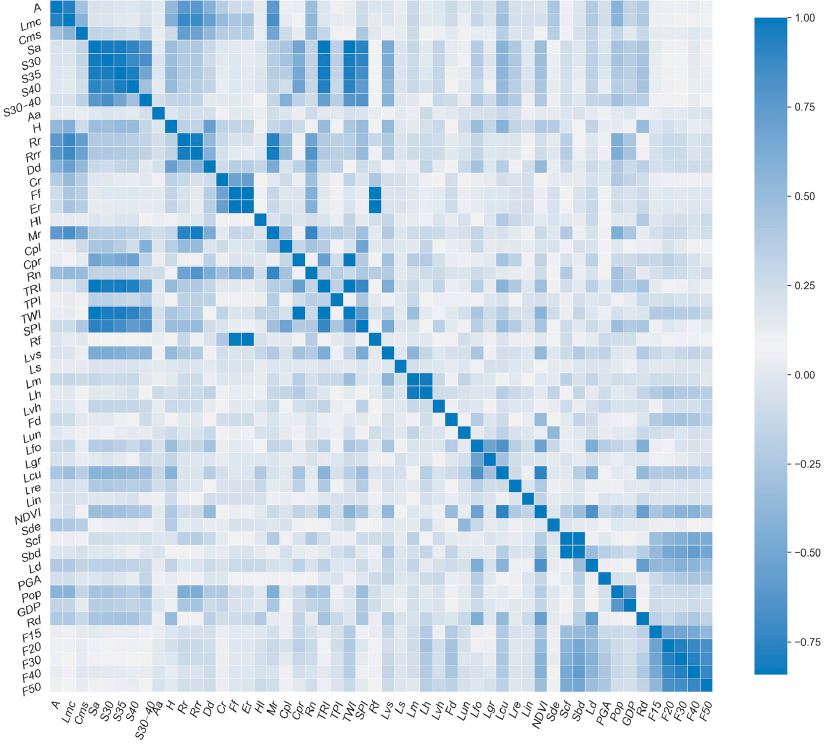
Figure 4. Cross-correlation heat map of the